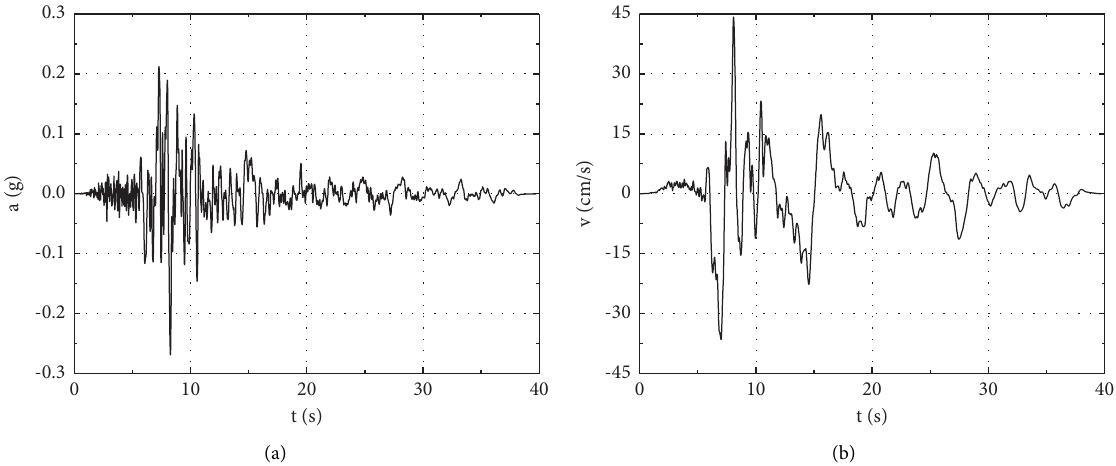
Figure 3: NS components of the No. 778 ground motion. (a) The acceleration time history. (b) The velocity time history.